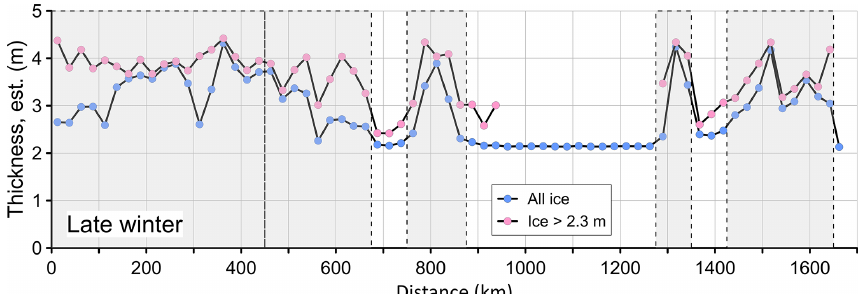
Figure 11. Average ice thickness for 25km segments of the track line at the end of the 2009–2010 winter, estimated by forcing ice growth with monthly climatological data for air temperature and snow depth, with the assumption that no new leads or ridges formed during the winter. Shading denotes intervals with appreciable multi-year ice.